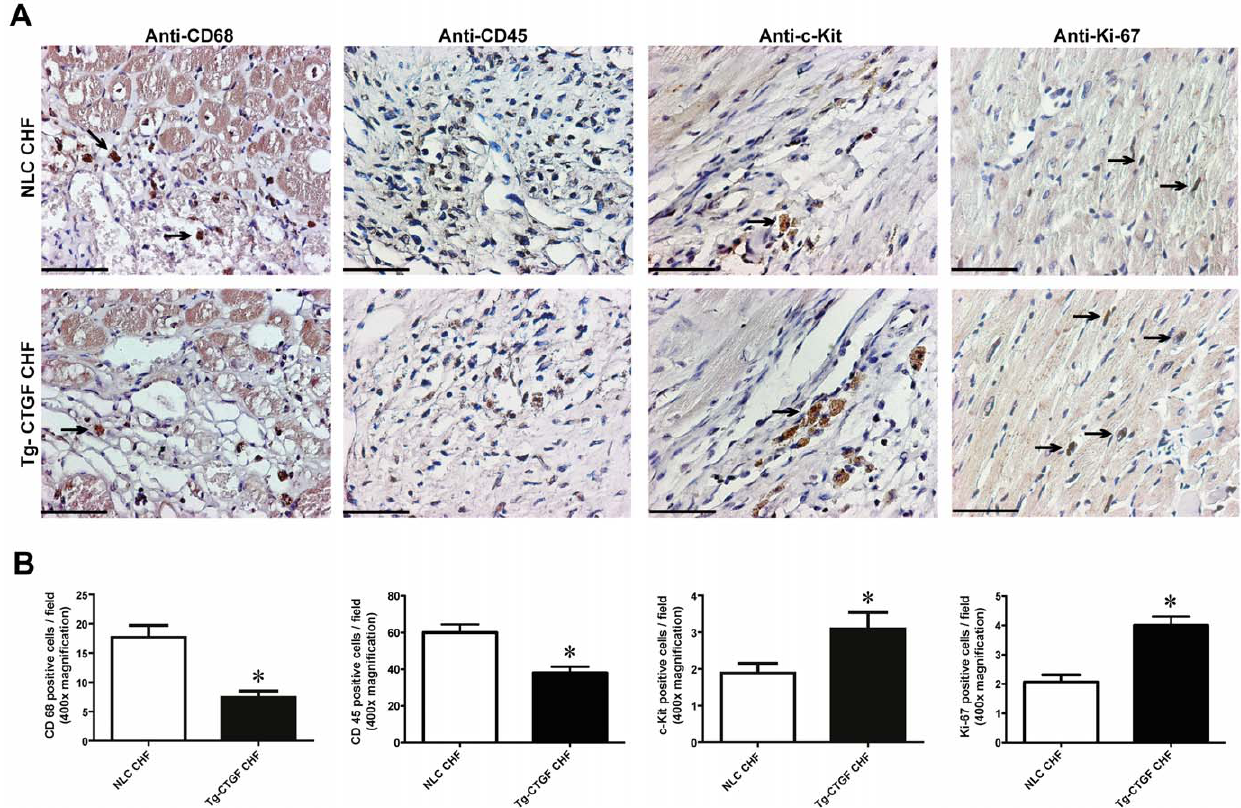
Figure 7. Morphometric analyses of inflammatory cells and cells undergoing apoptosis in myocardial tissue after MI. Photomicrographs of immunohistochemical staining of CD68, CD45, c-Kit and Ki-67 in myocardial sections of hearts from NLC mice and Tg-CTGF mice 4 weeks after MI. Panels are from border zone of MI. Size bar indicates 50 m m. Arrows indicate examples of immunoreactive cells. Magnification: 6 400. B. Histograms of CD68 + -cells, CD45 + -cells, c-kit + -cells and Ki-67 + -cells (immunoreactive cells/400x power field) in peri-infarct region of NLC CHF and Tg-CTGF CHF mice 4 weeks after ligation of LAD. 5 visual fields/section and 3 sections per mice were analyzed. Data are mean 6 SEM of Tg-CTGF CHF (n=4) and NLC CHF mice (n=4). * P , 0.05 vs. NLC CHF